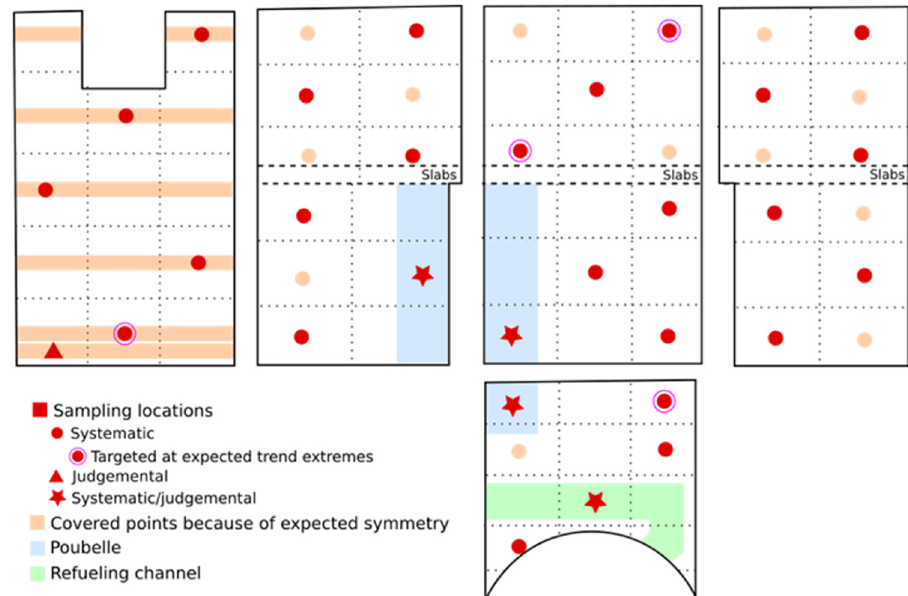
Fig. 4. Sampling plan for the BR3 biological shield (30 drill core samples).